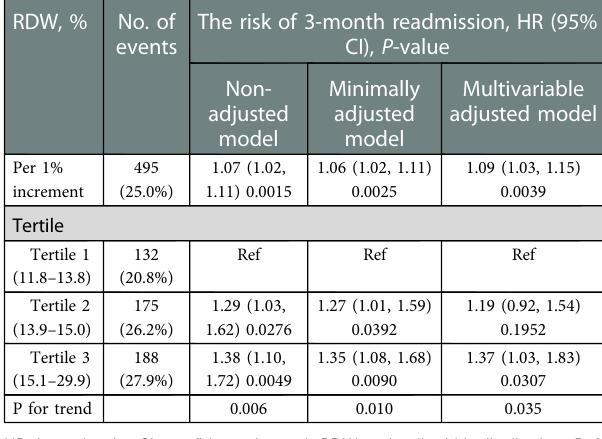
TABLE 3 Association of red cell distribution width with the risk of readmission within 3 months. RDW, % No.